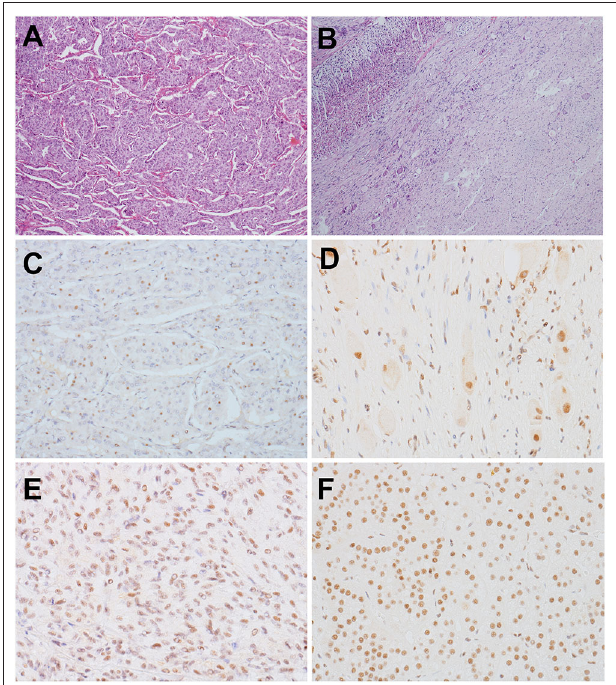
FIGURE 2 | (A,B) HE staining ( × 60). (A) PCC of the proband. The tumor exhibited an alveolar (Zellballen) pattern. Nests of mild polygonal cells were separated by peripheral capillaries. (B) GN of the proband’s son. The tumor located in the adrenal medulla, with a clear border to the adrenal cortex (left). The tumor was composed of scattered ganglion cells in the background of Schwannian stroma. (C–F) Detection of MAX by immunohistochemistry with a MAX C-terminus-specific antibody ( × 300). (C) Most tumor cells in PCC of the proband were negatively stained, but some tumor cells were positive. (D) The scattered ganglion cells and some Schwannian cells in GN of the son of the proband showed positive staining for MAX, but other Schwannian cells were negatively stained. (E) Positive staining of tumor cells in a RET-mutated PCC. (F) Positive staining of the normal adrenal cortex of the patient with GN.